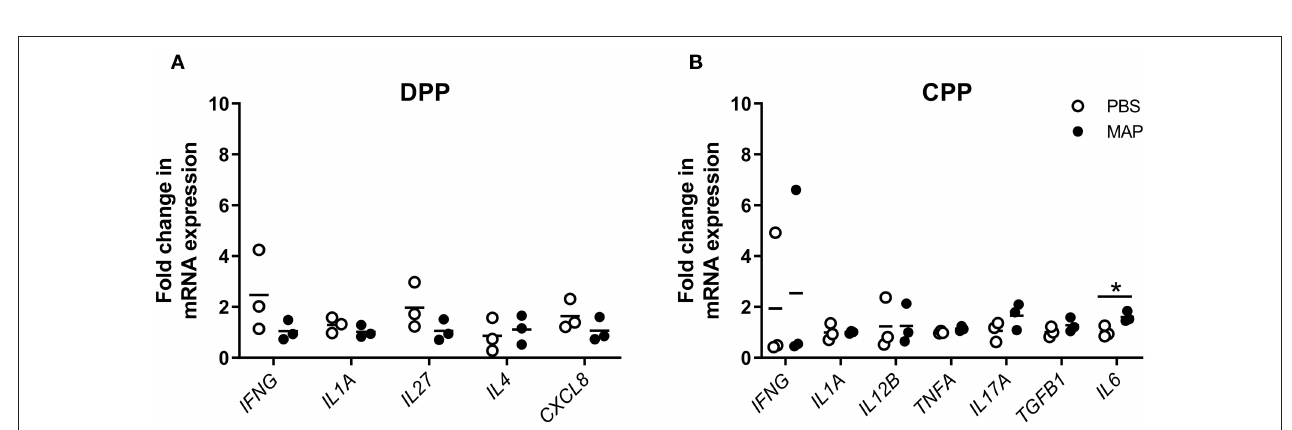
FIGURE 7 | Differential cytokine gene expression in PP tissue from MAP-infected segments compared to PBS control segments at 2 months post-infection. Transcript abundance for 23 cytokine genes (assessed using the primers described in Supplementary Table 1 ) was quantified by qRT-PCR in (A) MAP-infected ( n = 3) and syngeneic PBS control ( n = 3) DPP tissue, and (B) MAP-infected ( n = 3) and syngeneic PBS control ( n = 3) CPP tissue collected from a previous study ( 34). Each data point represents the fold change for each individual animal relative to the mean of the PBS control segments. Data presented are for cytokine genes showing differential (* p < 0.05) gene expression in MAP-infected segments relative to PBS control segments at 2 months post-infection, in addition to those cytokine genes that were identified as differentially expressed at 12 months post-infection ( Figure 6 ).